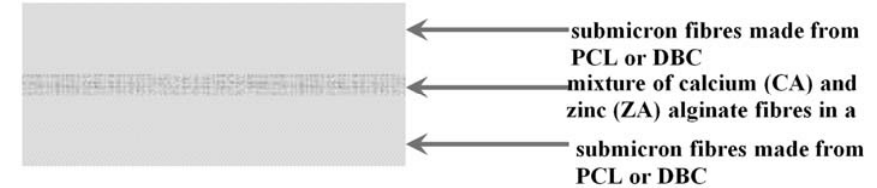
Figure 14. Diagram of variant II